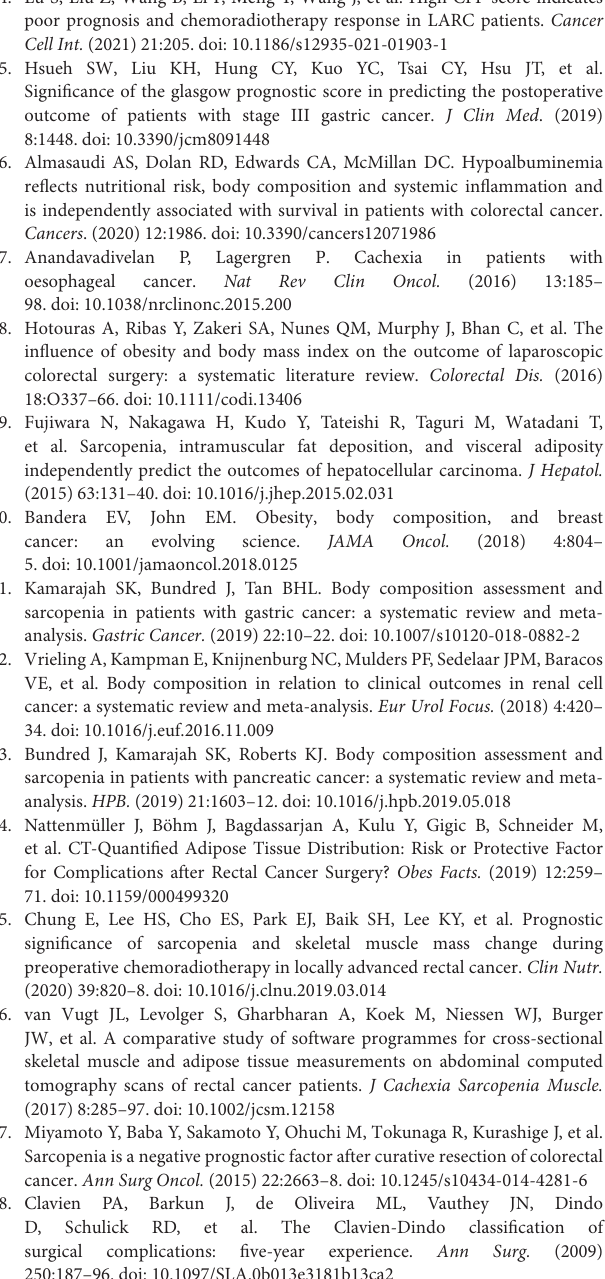
v1.47i (National Institutes of Health, Bethesda, MD). The area delineated by the yellow solid line represents the region of interest. Supplementary Figure 2 | Time-dependent ROC of body composition and the change of body composition for DFS (A) and CSS (B) . Supplementary Figure 3 | Kaplan-Meier analysis for DFS according to body composition and change of body composition. Supplementary Figure 4 | Kaplan-Meier analysis for CSS according to body composition and change of body